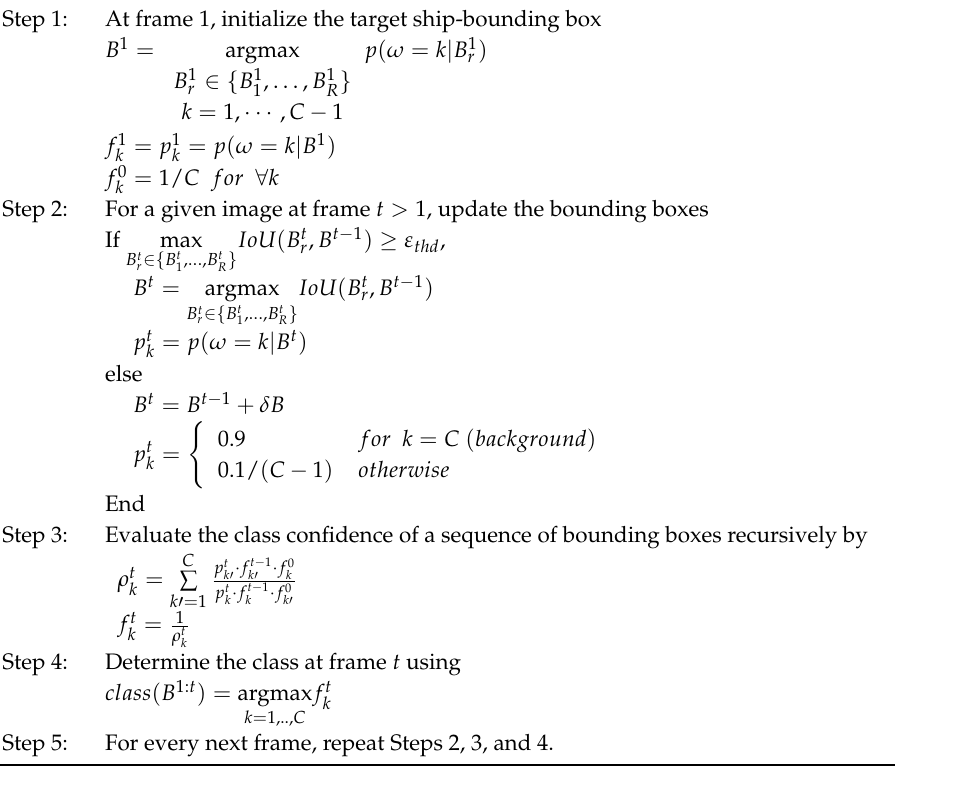
Algorithm 1: Probabilistic ship detection and classification from video.